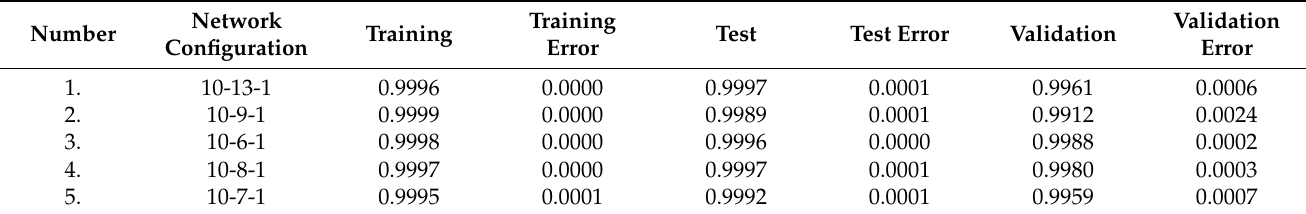
Table 1. Characteristics of ANN for predicting glycerol concentration.